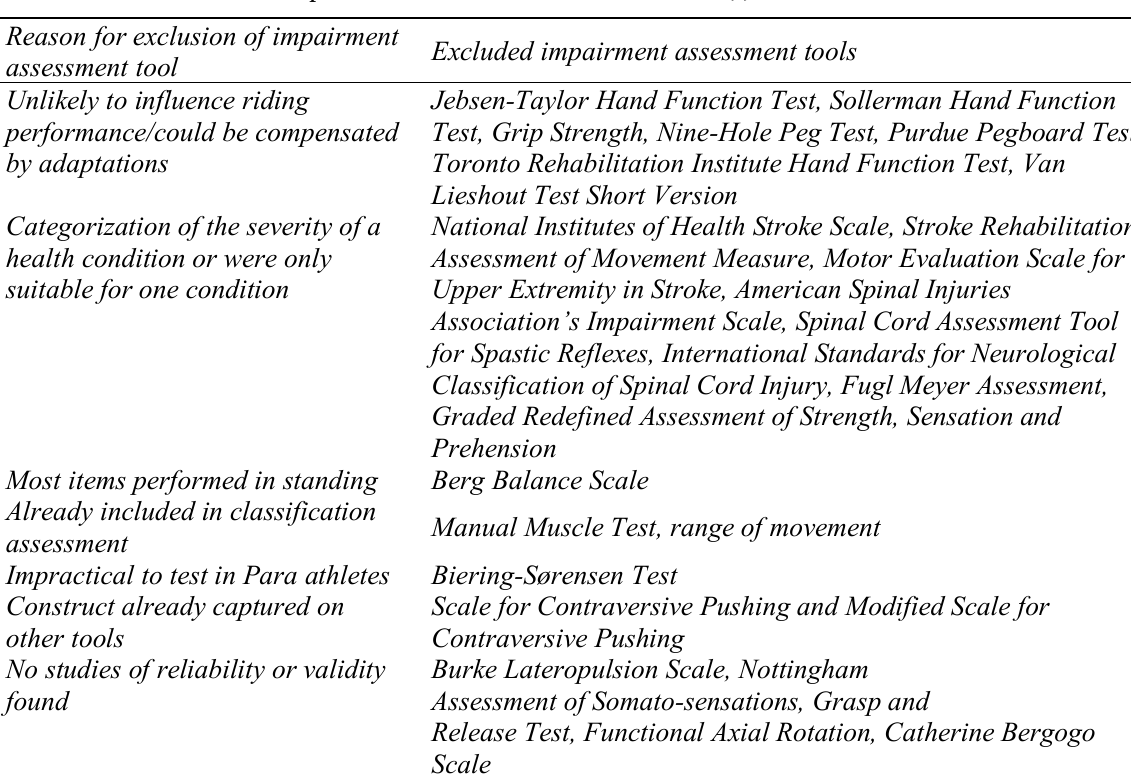
Table 2. List of excluded impairment assessment tools and the reason(s) for their